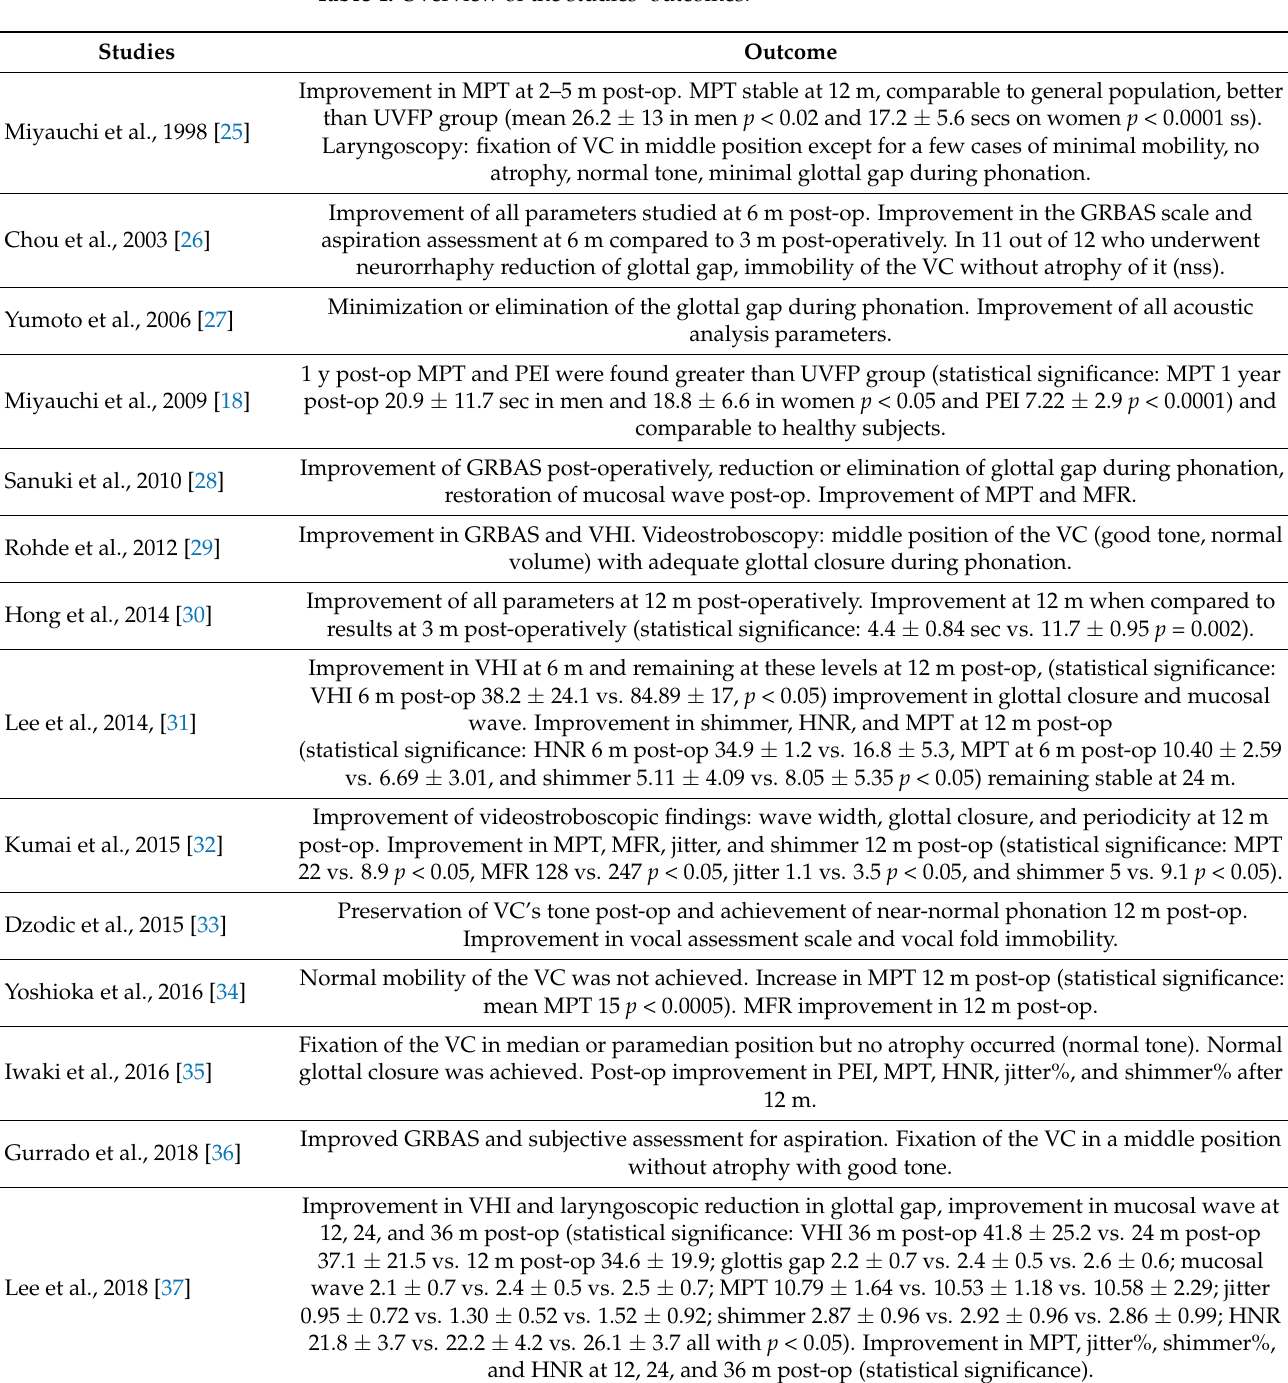
Table 4. Overview of the studies’